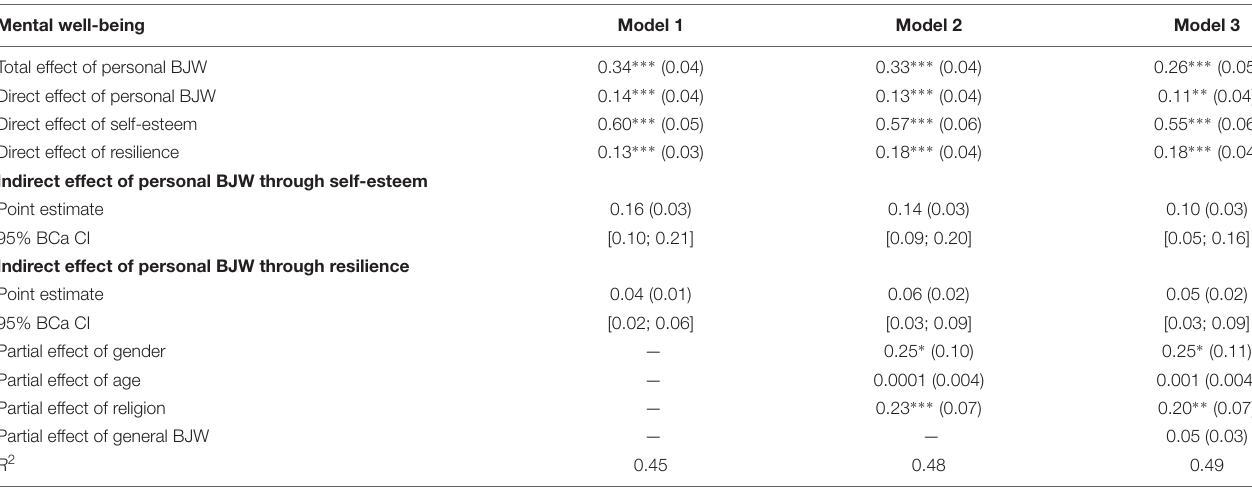
TABLE 5 | Results from bootstrap mediation analyses for mental well-being ( N = 352). Mental